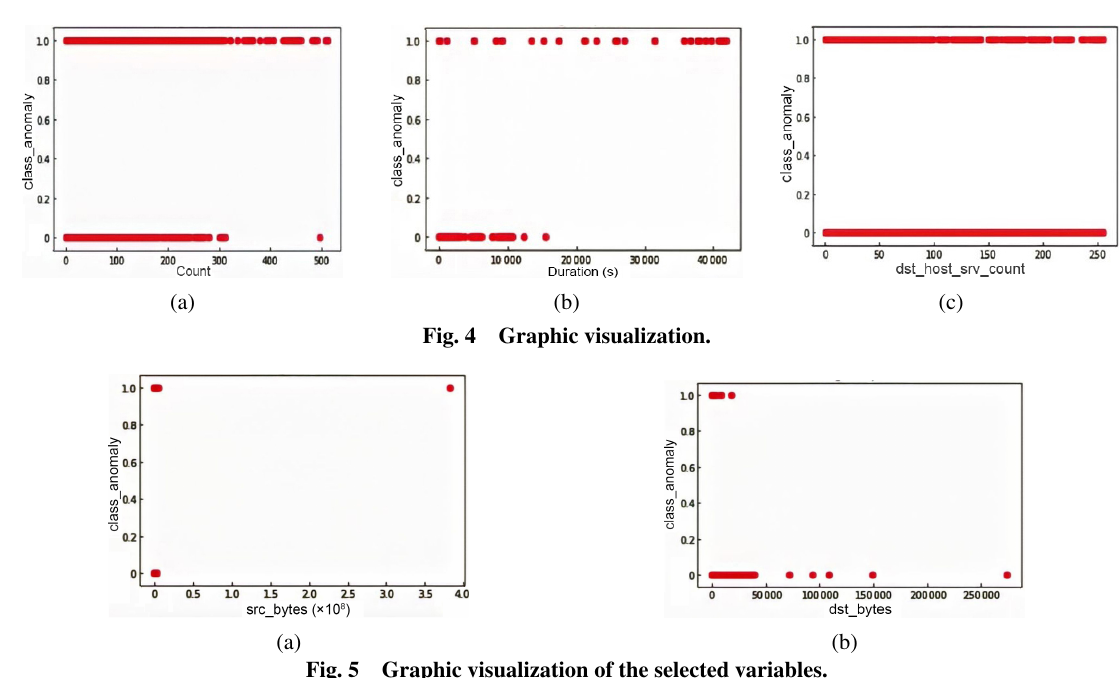
Fig. 5 Graphic visualization of the selected